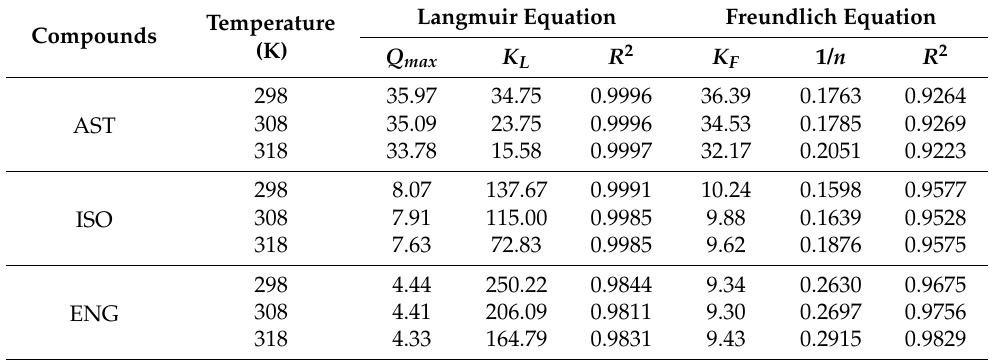
Table 2. Langmuir and Freundlich adsorption parameters of AST, ISO, and ENG on HPD-300 resin. Compounds